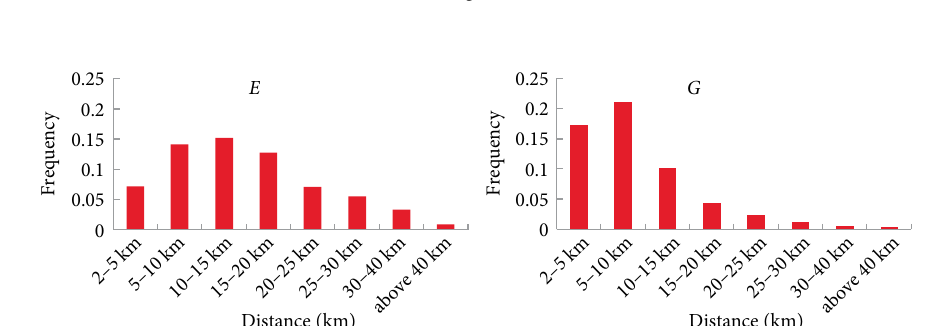
Figure 9: Driving time distribution.